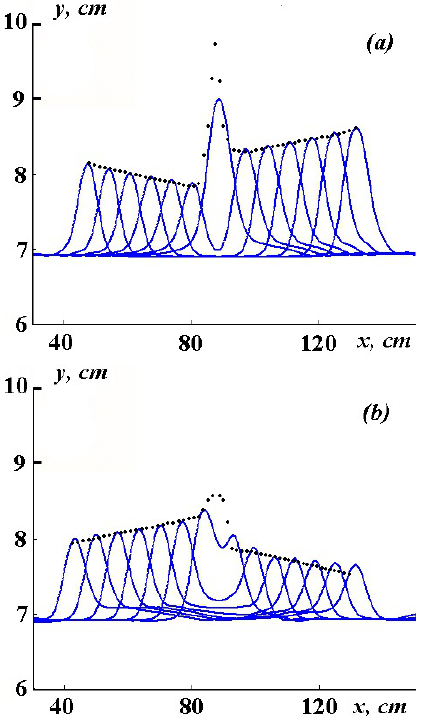
Fig. 5. The decay of symmetric solitary waves moving toward each other. Bold points represent the experimental positions of wave crests through the regular time interval (1s). Solid lines show the calculated wave profiles through the fixed time interval (4s): (a) waves before interaction ( t < 24s); (b) waves after interaction ( t > 24s).